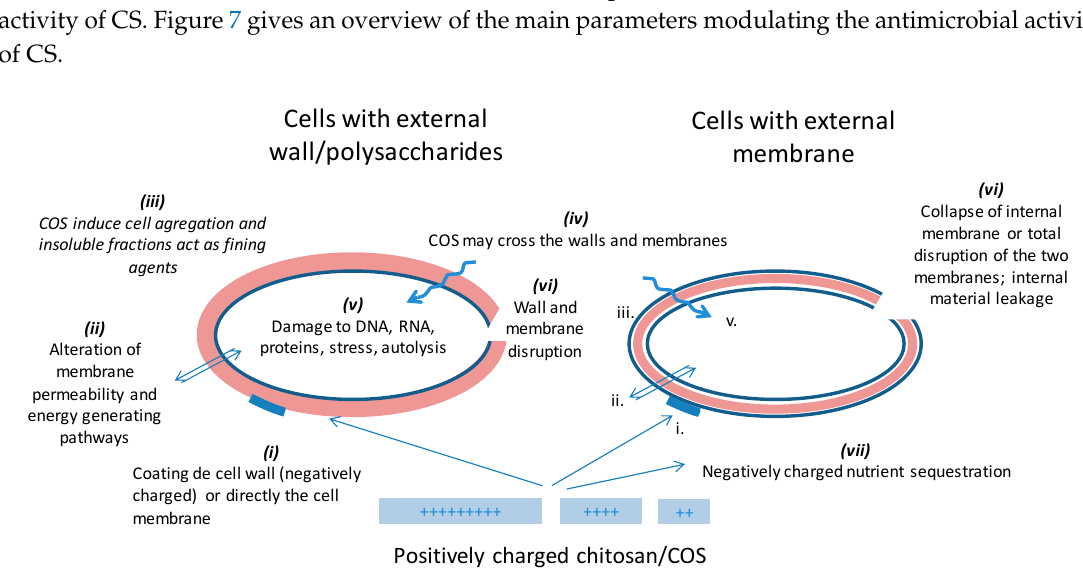
Figure 6. Inventory of the different molecular processes that may contribute to the chitosan antimicrobial activity (adapted from [79]). The numbers (i) to (vii) correspond to those used in the text (see above).